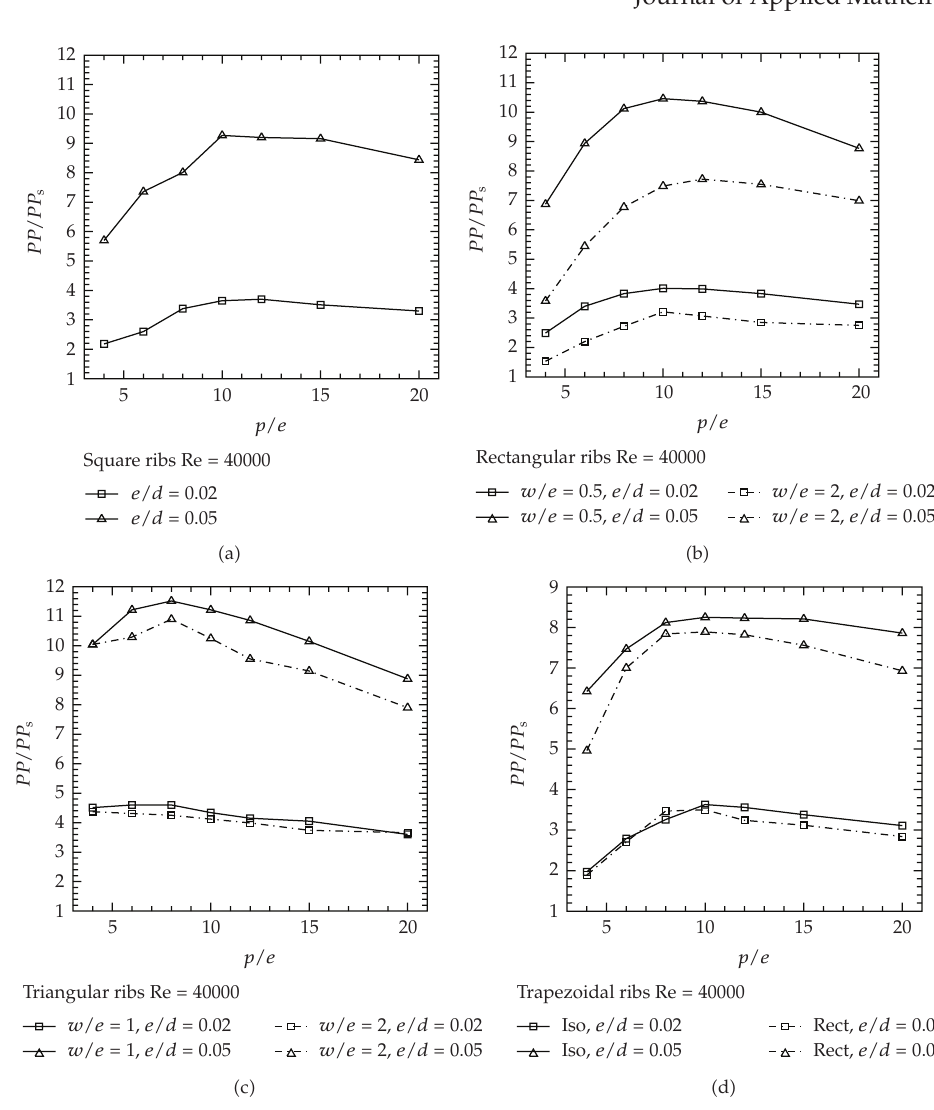
Figure 8: Required pumping power profiles, referred to the smooth channel results, as a function of p/e at Re (cid:8) 40000, for e/d (cid:8) 0 . 02 and 0.05: (cid:6) a (cid:7) square-ribs, (cid:6) b (cid:7) rectangular ribs with w/e (cid:8) 0 . 5 and 2.0, (cid:6) c (cid:7) triangular ribs with w/e (cid:8) 1 . 0 and 2.0, and (cid:6) d (cid:7) isosceles and rectangular trapezoidal ribs with w/e (cid:8) 2 .